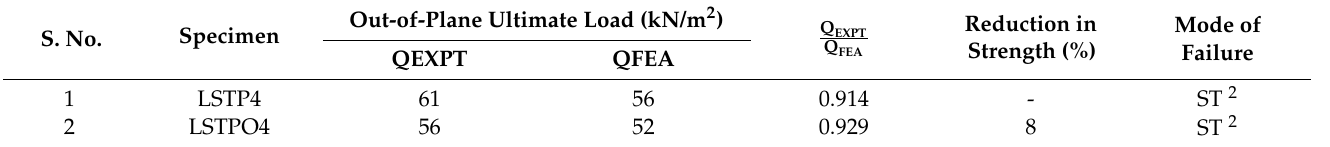
Table 6. Out-of-plane ultimate loads obtained from experiment and finite element analysis. S.